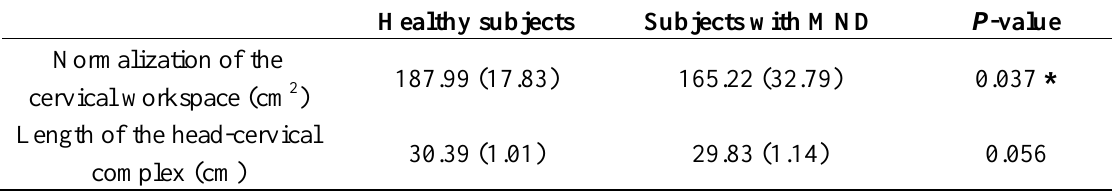
Table 2. Comparison of the normalization of the cervical workspace with respect to the length of the head-cervical complex and the length of the head-cervical complex between healthy subjects and patients with